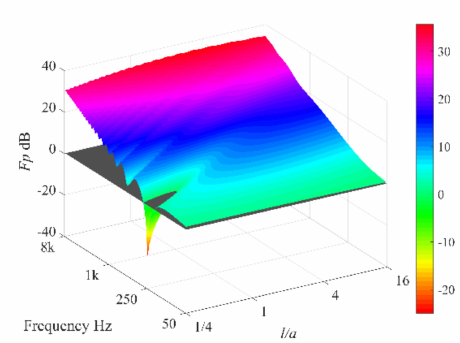
Figure 2. Theoretical amplification at the focus when the diameter is constant.